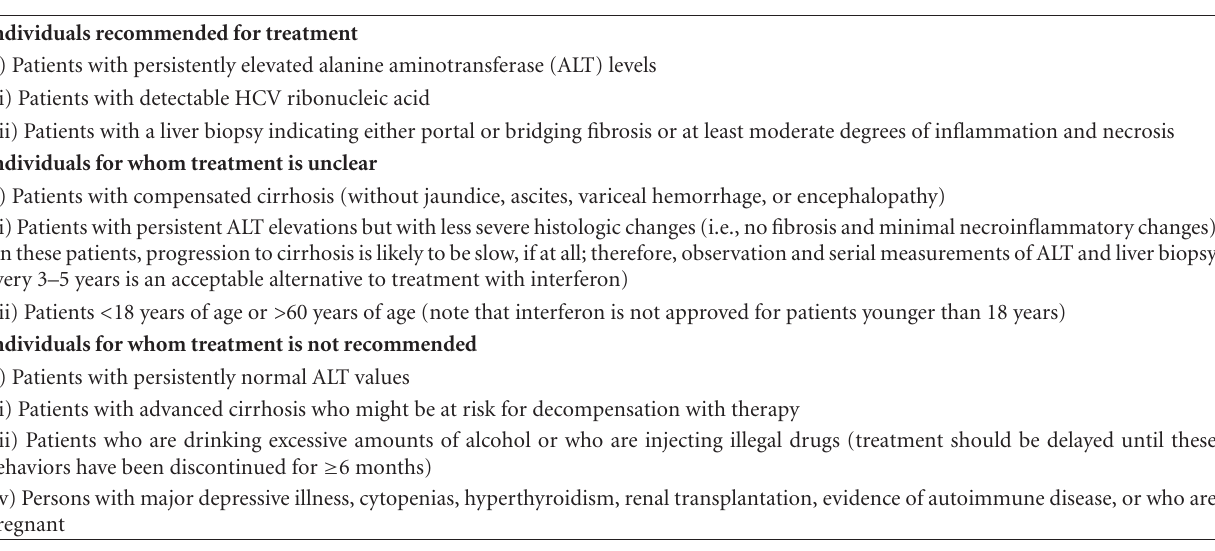
Table 1: Treatment groups for patients with hepatitis C virus (HCV)